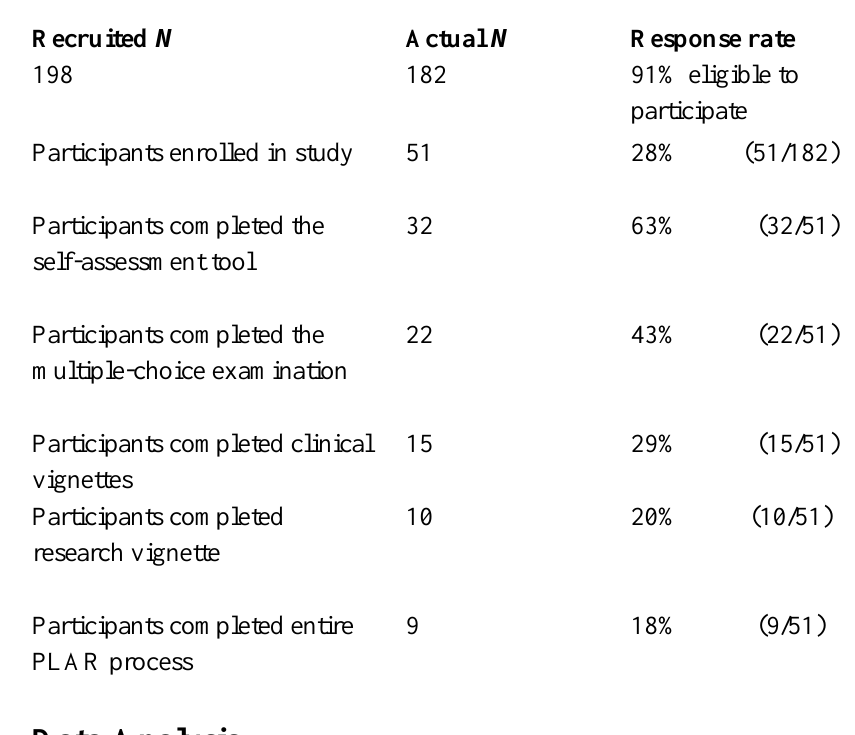
Response Rates for Each Component of the PLAR Recruited